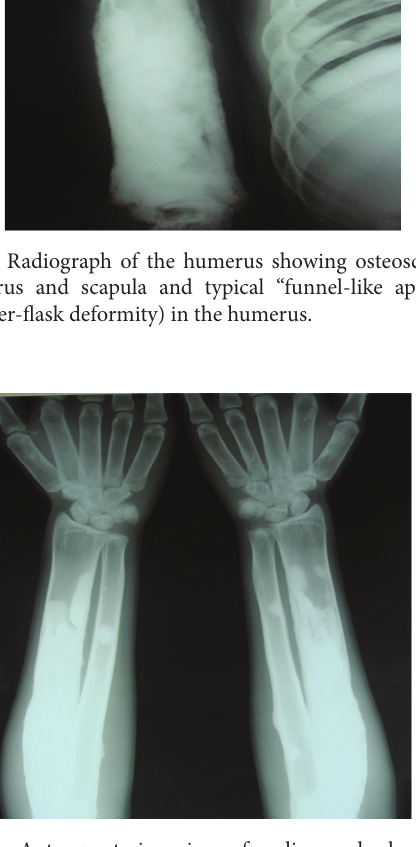
Figure 12: Anteroposterior view of radius and ulna showing increased radiodensity in all the bones, smoothening of the bone surfaces, and cylindrical appearance of the metacarpals.